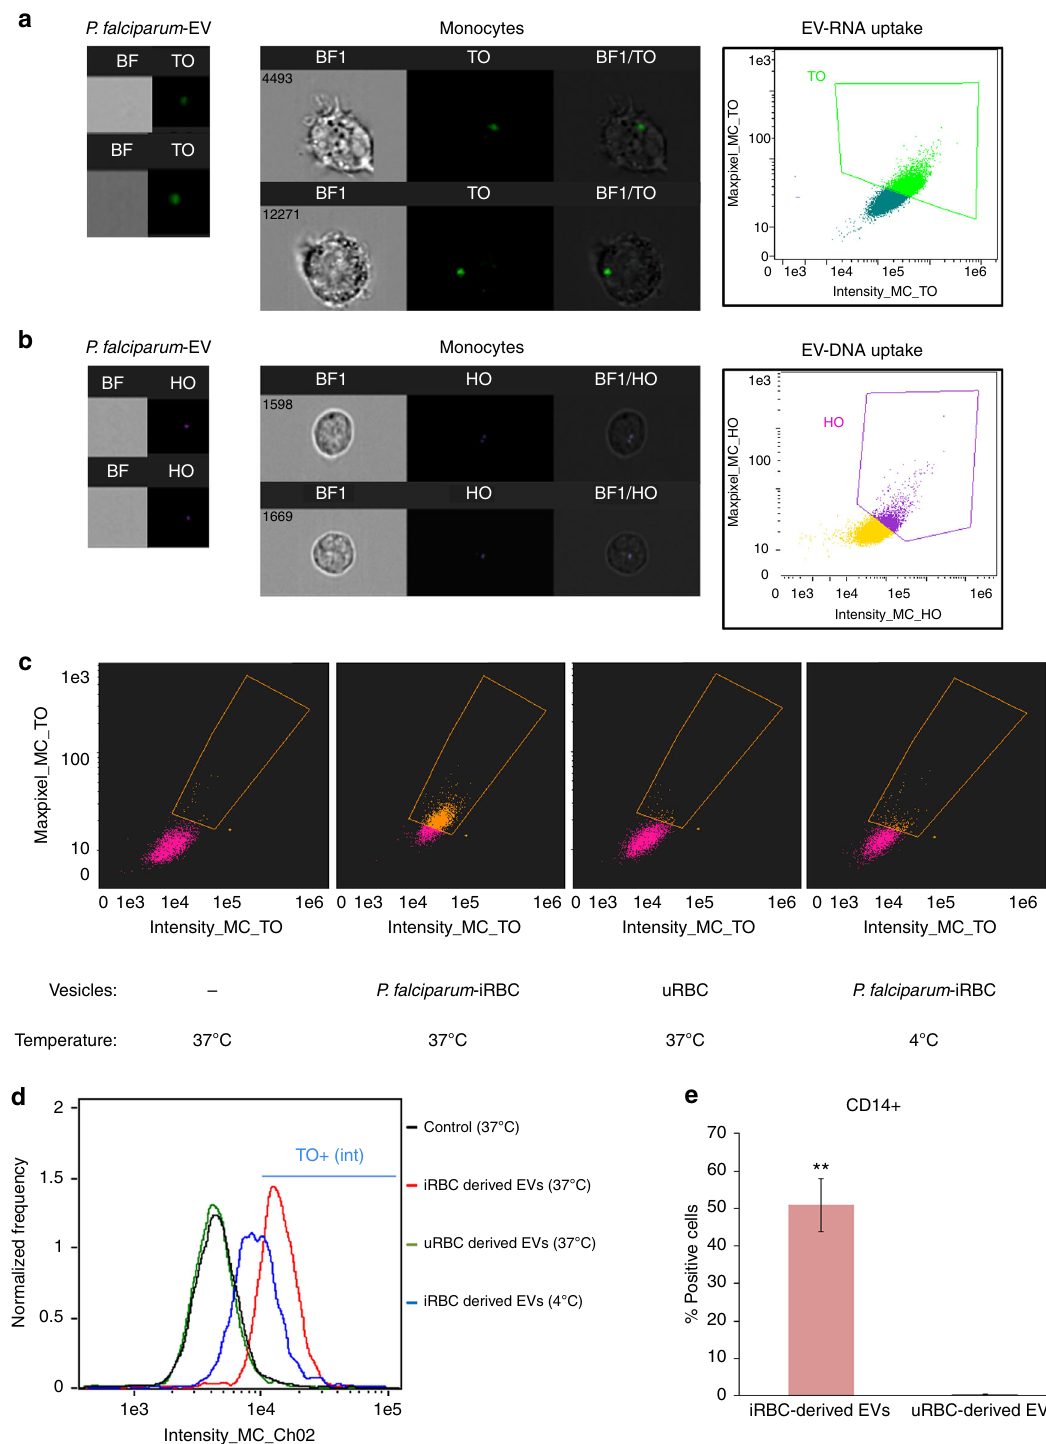
Fig. 5 P. falciparum EV intake by monocytes. a THP-1 cells were incubated with RNA (TO)-labeled vesicles derived from P. falciparum -iRBCs and imaged by IFC. Graphs show (green) TO-labeled positive cells, gated according to unlabeled cells. b THP-1 cells were incubated with DNA (HO)-labeled vesicles derived from P. falciparum -iRBCs and imaged by IFC. Graphs show (purple) HO-labeled positive cells, gated according to unlabeled cells. c THP-1 cells were incubated with RNA (TO)-labeled vesicles derived from P. falciparum -iRBCs or uRBCs or THP-1 cells were incubated with RNA (TO)-labeled P. falciparum EVs at 4 °C and imaged by IFC. Graphs show (orange) TO-labeled positive cells, gated according to unlabeled cells. d Histograms of image stream analysis data in c . e PBMCs were obtained from nine different healthy donors and were incubated with TO-(RNA)-labeled P. falciparum -derived EVs; monocytes were stained for CD14 and imaged by IFC. Graphs present the percentage of TO-labeled positive cells, gated according to unlabeled cells from three repeats. SD and T -test analysis ** p ≤ 0.001. TO Thiazole Orange (for RNA staining), HO Hoechst (for DNA